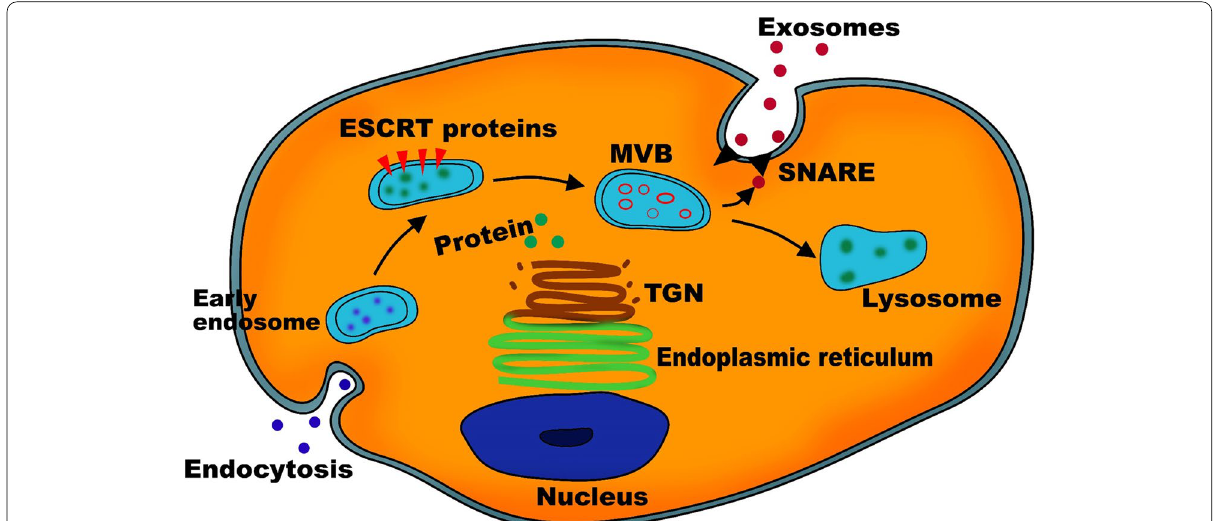
Fig. 1 Exosome biogenesis starts with the endocytosis and early endosome (EE) formation. In addition to extracellular cargo that gets to the EE, it receives cargo and protein from the trans-face of the Golgi network (TGN). The cargo undergoes meticulous surveillance and multivesicular body (MVB) containing the intraluminal vesicles (ILV). The cargo that should be degraded is trafficked toward the lysosome while the exosomes are carried on SNARE proteins to help it dock on the cytoplasmic membrane to be excreted as